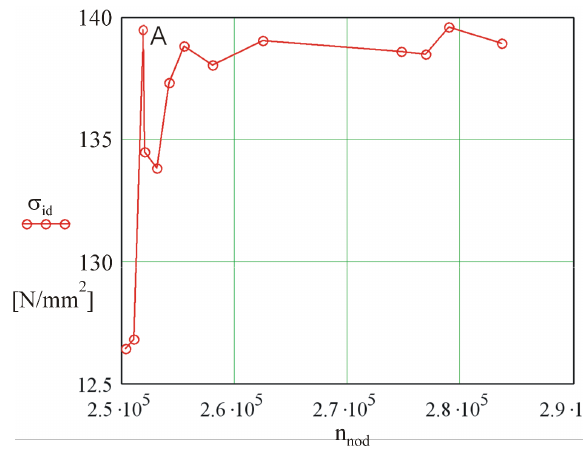
Figure 25: Convergence curve relative to the maximum stress σ id indicated in Figure